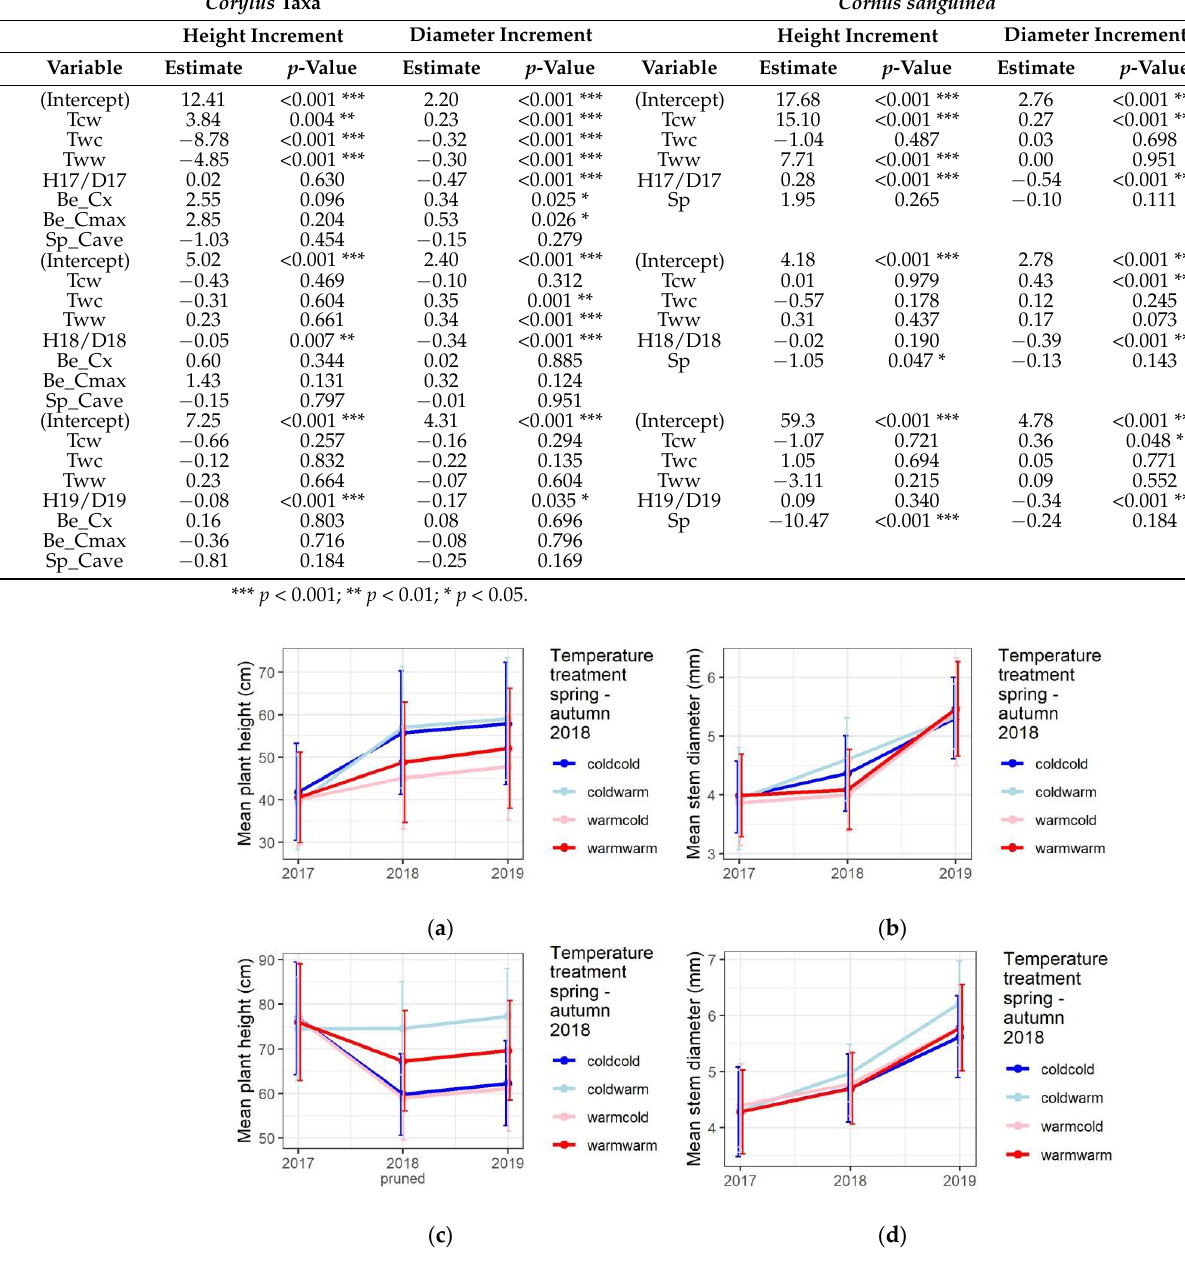
Figure 3. Mean and standard deviation of height ( a , c ) and diameter ( b , d ) measurements of the Corylus taxa ( a , b ) and Cornus sanguinea ( c , d ) according to the temperature treatments in 2018.